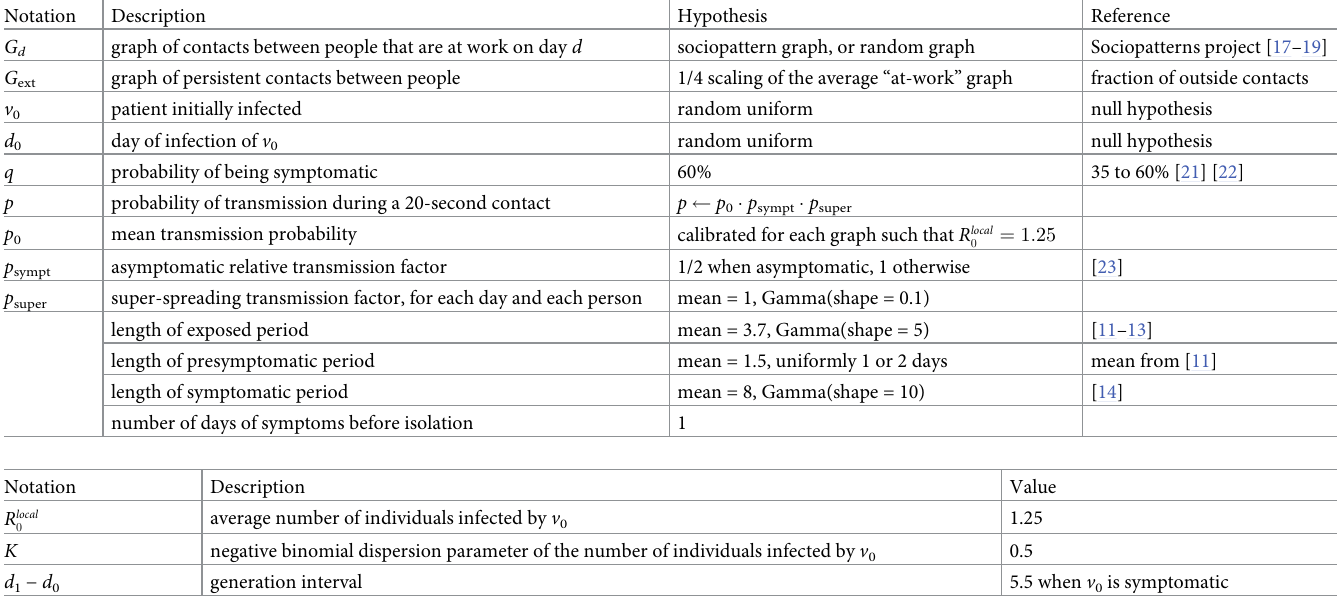
Table 2. The top table gives the parameter values used in our simulations, with the supporting references. The bottom table summarizes some relevant quantities that can be computed from our simulations: their consistency with the literature is argued in the Discussion